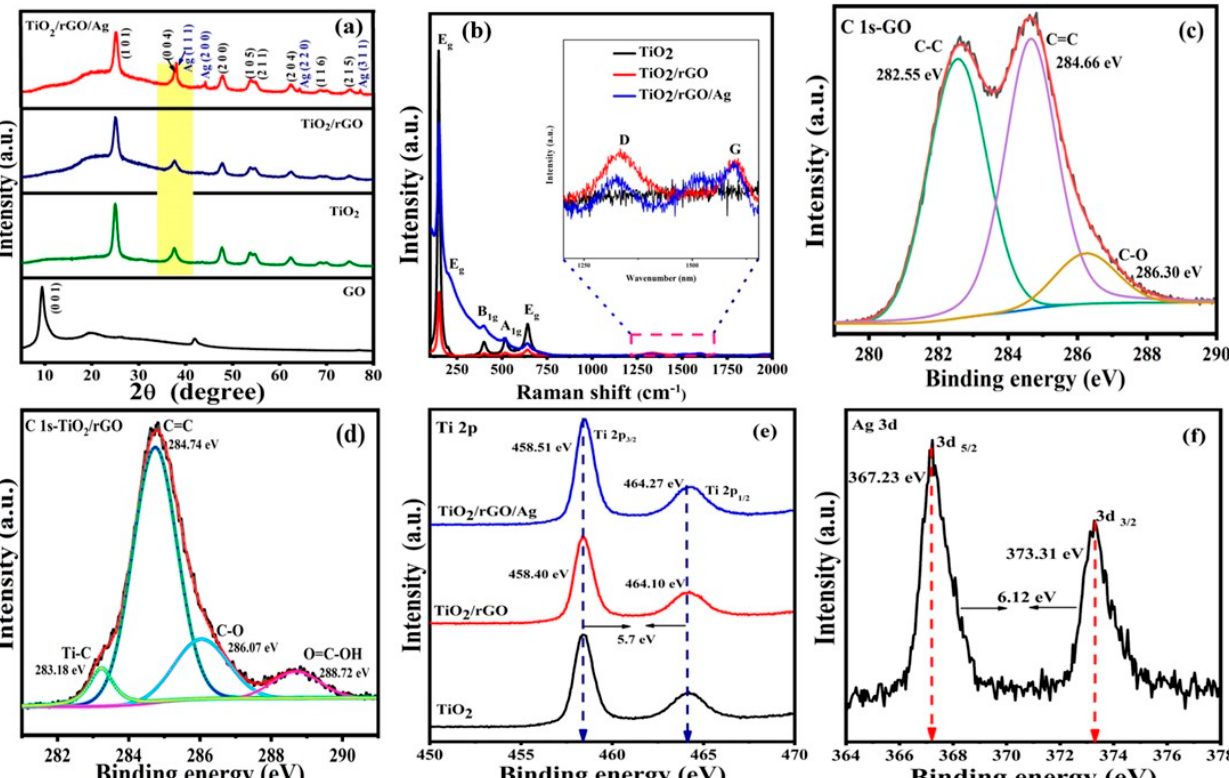
Figure 1. ( a ) XRD patterns, ( b ) Raman spectra of GO, mesosphere TiO 2 , TiO 2 /rGO and TiO 2 /rGO/Ag. XPS core level spectra of the ( c ) C1s spectra of GO; ( d ) C 1s spectra of TiO 2 /rGO; ( e ) Ti 2p spectra of mesosphere TiO 2 , TiO 2 /rGO and TiO 2 /rGO/Ag; ( f ) Ag 3d spectra of TiO 2 /rGO/Ag.